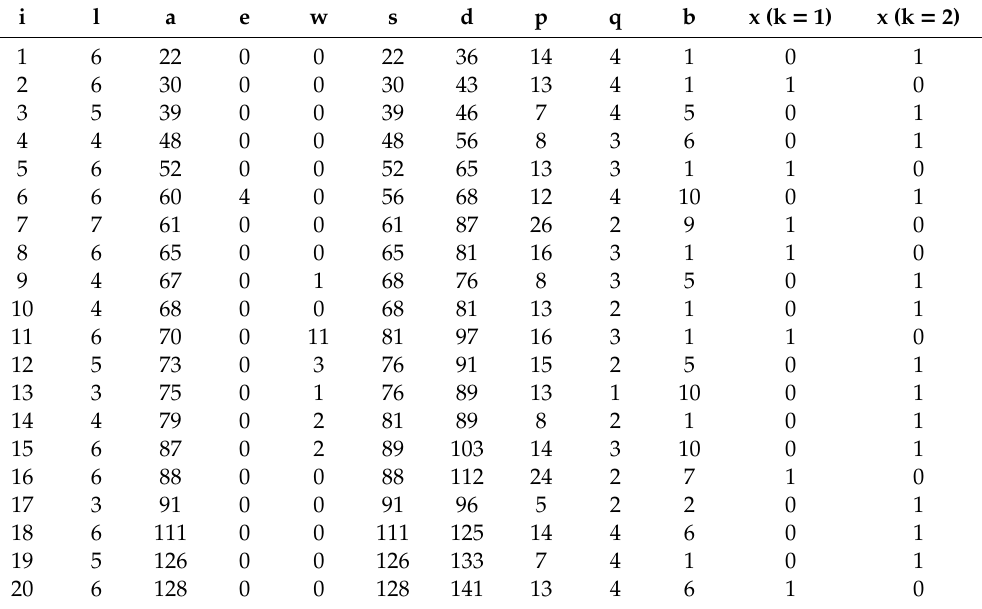
Table A7. Results of the integrated BAP and QCAP solution for Case 17: seed = 700, λ = 3.5, Z (cid:48) =